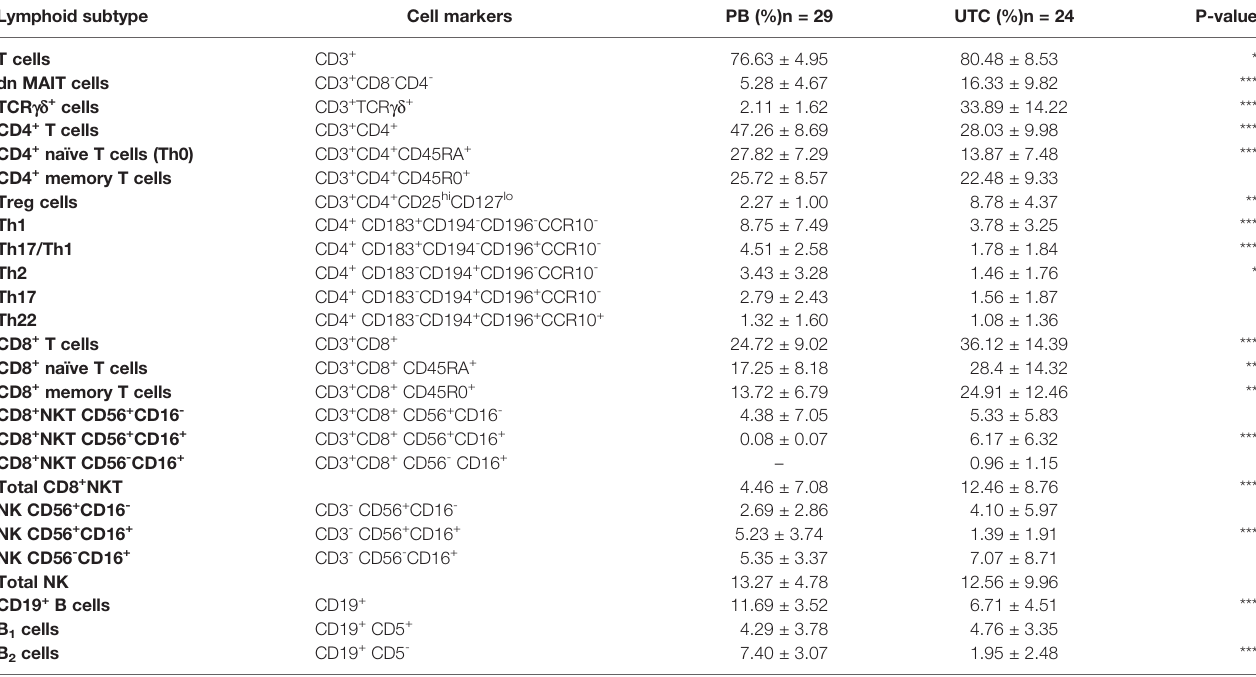
TABLE 3 | Lymphoid subset proportions in peripheral blood (PB) and upper tarsal conjunctiva (UTC) in healthy individuals. Lymphoid subtype